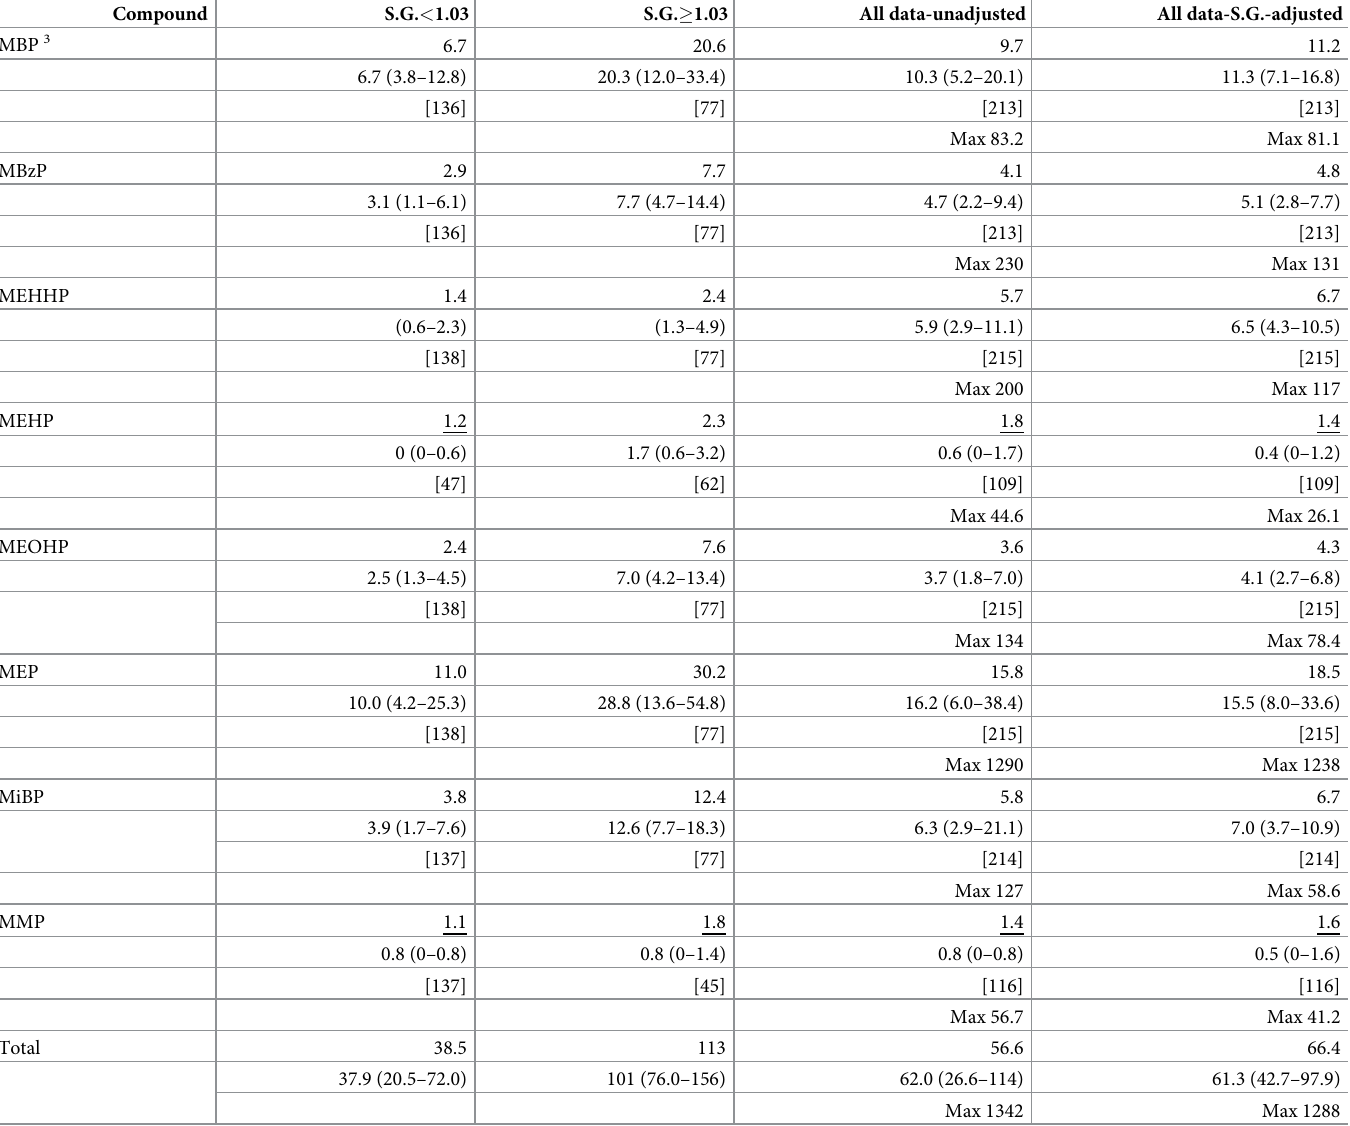
Table 1. Summary of measured urinary phthalate metabolite concentrations. Geometric mean 1 , median (and interquartile range) concentrations (ng/mL) and number [N] above and below specific gravity (S.G.) of 1.03 in addition to unadjusted and S.G.-adjusted (using sample mean S.G.) concentrations for the entire dataset. Maximum concentrations detected in the entire dataset (all data) [N = 215] are also given 2